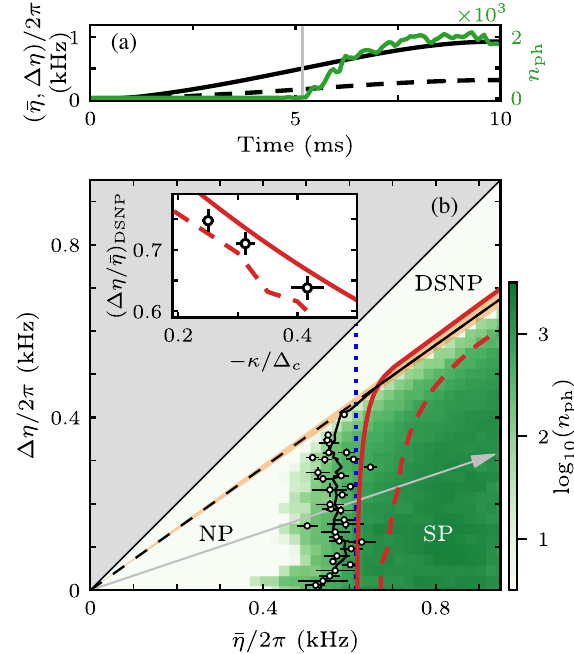
FIG. 2. Phase diagram. (a) Experimental protocol. We ramp up the couplings ¯ η (solid black line) and Δ η (dashed black line) within 10 ms at constant ratio Δ η = ¯ η . A typical time trace of the mean intracavity photon number n for Δ η = ¯ η ¼ 0 . 34 is shown ph (green line). For any Δ η = ¯ η < 0 . 71 ð 2 Þ , a coherent cavity field builds up in the cavity (superradiant phase) above a critical coupling (gray vertical line). (b) Green: intracavity photon number n as a function of the couplings ¯ η and Δ η , obtained by ph implementing the protocol shown in (a) for 51 different values of Δ η = ¯ η and averaging over five repetitions. Labels NP, SP, and DSNP stand for normal, superradiant, and dissipation- stabilized normal phase, respectively. The dots indicate the critical point extracted from the measured photon traces and averaged within each subset of constant Δ η = ¯ η with the error bars representing the standard error of the mean (SEM). The slope ð Δ η = ¯ η Þ of the dashed line corresponds to the smallest DSNP value of Δ η = ¯ η at which the SP is not present (the uncertainty on the slope is marked as a shaded orange region around the line). The black line is a guide to the eye through the critical points (obtained as a sliding average over seven points) and along the measured boundary of the DSNP. We mark the boundary of the SP obtained from a mean-field stability analysis (solid red line) and from a numerical simulation of the measurement protocol (dashed red line) [8]. For comparison, the analytical mean-field result for the closed system is also plotted (blue dotted line). The arrow indicates the measurement path followed in (a). Inset: slope ð Δ η = ¯ η Þ extracted from phase diagrams mea- DSNP and plotted vs − κ = Δ . sured at different cavity detunings Δ c c The upper (lower) vertical error bar corresponds to the smallest (largest) value for ¯ η = Δ η at which the phase transition is always absent (present), while the horizontal ones arises from the uncertainty of Δ . The lines are predictions from analytical c (solid) and numerical (dashed) calculations. For this measure- ment, N ¼ 1 . 28 ð 8 Þ × 10 5 , ω 0 ¼ 2 π · 44 ð 2 Þ kHz, and, in (a) and − 2 π · 4 . 0 ð 2 Þ (b), Δ c ¼